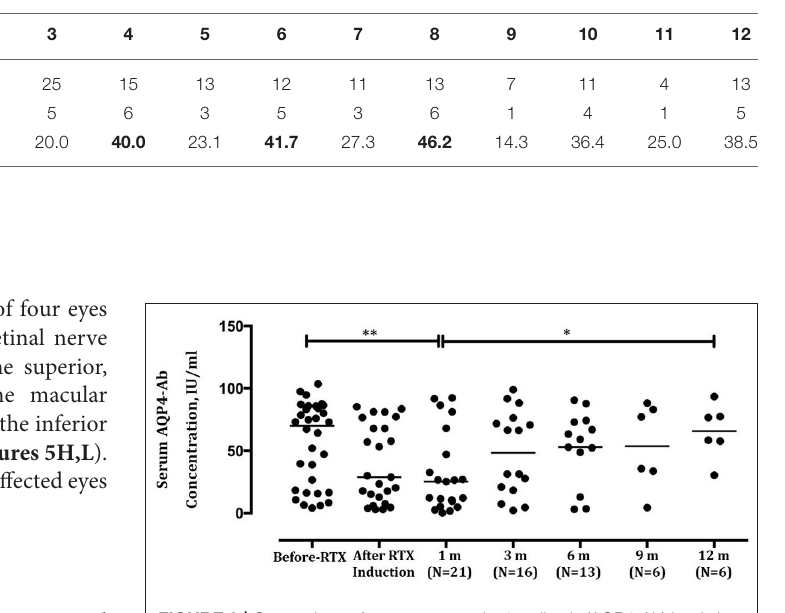
FIGURE 3 | Comparison of serum aquaporin-4 antibody (AQP4-Ab) levels in neuromyelitis optica-associated optic neuritis patients before and after low-dose rituximab induction within 12 months. ** P < 0.01; * P <